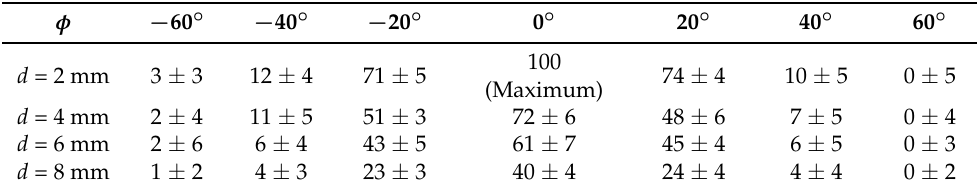
Table 4. Normalized intensity loss (as a percentage of the maximum) in Fiber-1 with 1 N external